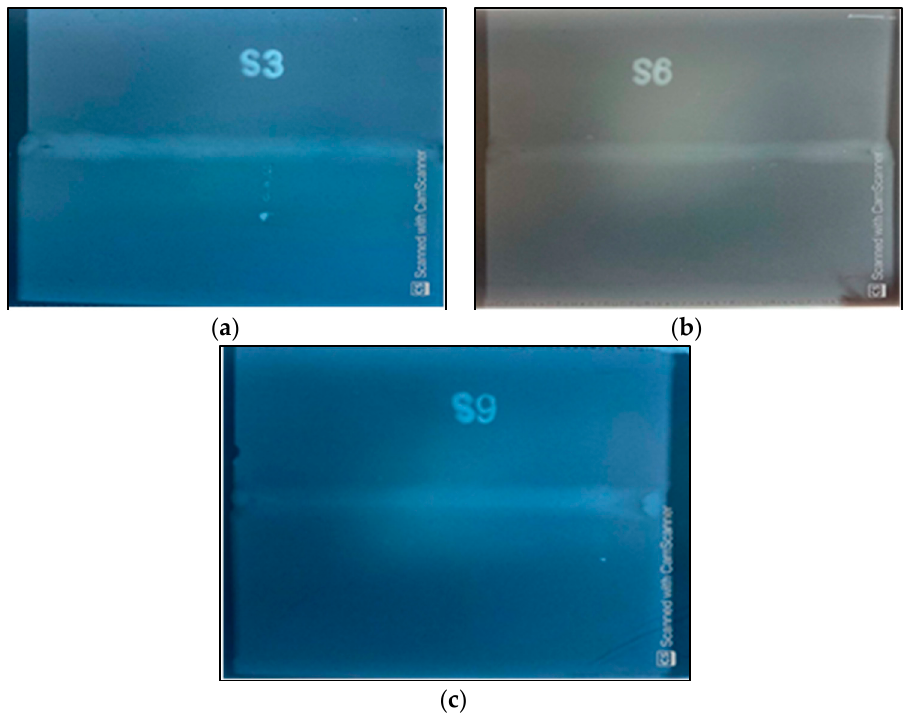
Figure 2. X-ray radiographic results of ( a ) experiment No. 3, ( b ) experiment No. 6 and ( c ) experiment No. 9. Table 4. Orthogonal array (L9) experimental